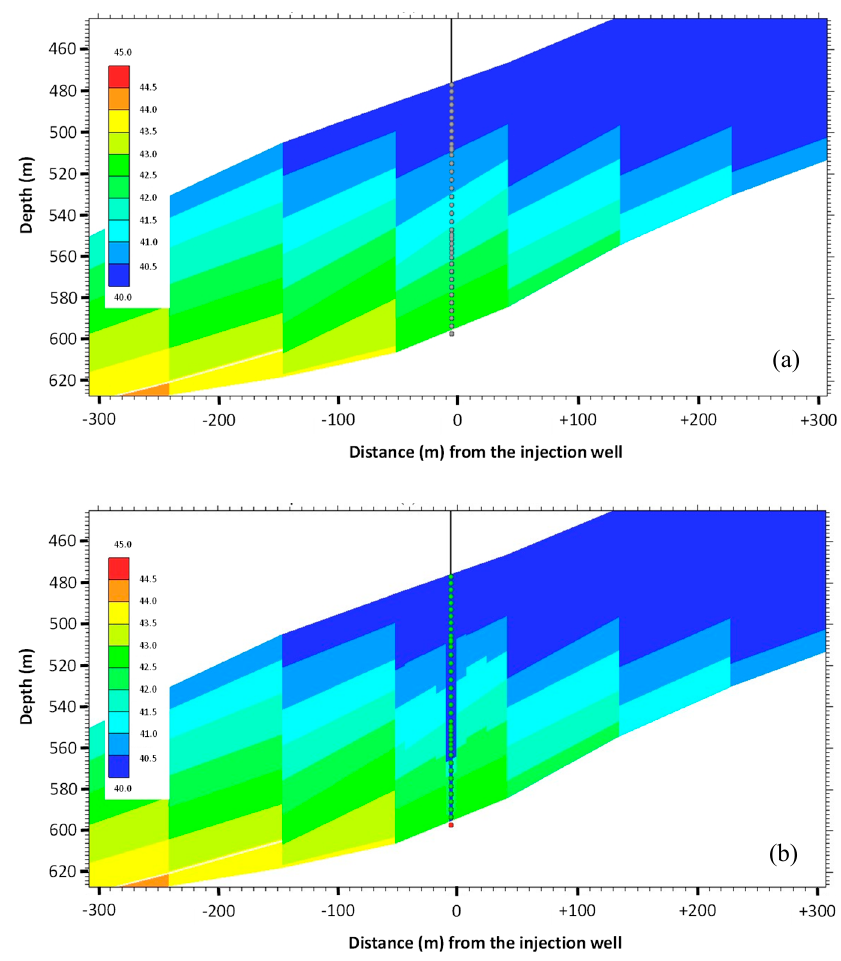
Figure 14. The simulated vertical cross-section fracture around the injection well of the time-evolution of temperature during the two-phase CO 2 -brine initial ( a ) and final ( b ) injection periods. The distance to the well is a positive up dip and the depth is expressed with respect to the mean sea level.